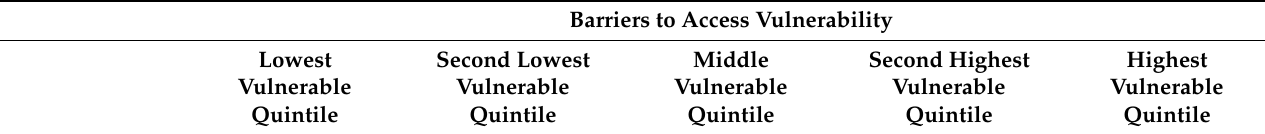
Table 3. Neighborhood socio-demographic characteristics by level of barriers to accessing health care.